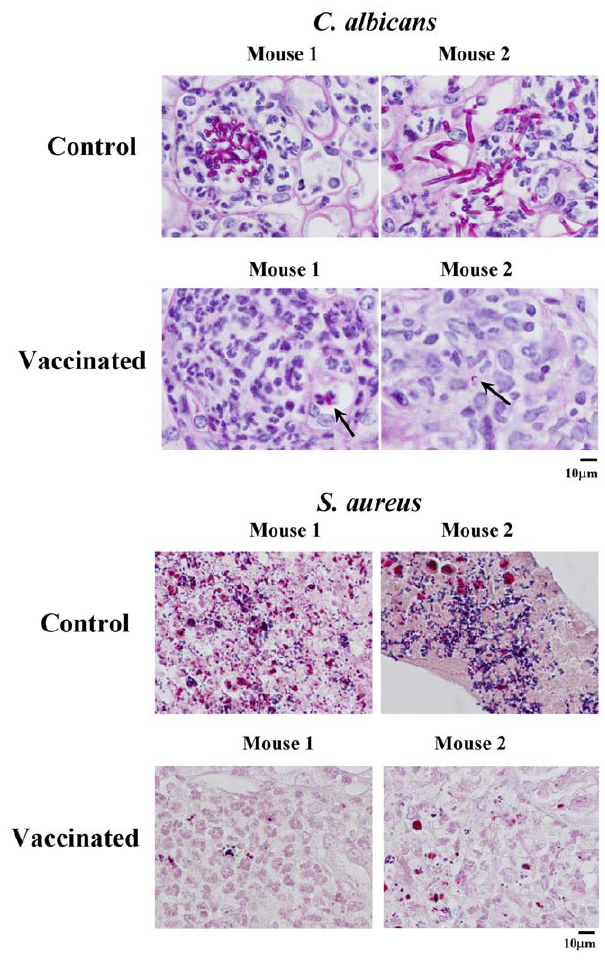
Figure 8. Unvaccinated mice had less neutrophil influx relative to fungal and bacterial burden than vaccinated mice. Represen- tative histopathological sections from kidneys from 2 mice per group are shown. Control mice infected with C. albicans had multiple abscesses with visible hyphae and pseudohyphae throughout the kidneys. Vaccinated mice infected with C. albicans had abscesses, but with far less fungus visible. Numerous abscesses were seen in both vaccinated and control mice infected with S. aureus . However, overall the abscesses in the control mice infected with S. aureus had considerably more bacteria by gram stain than the abscesses in the vaccinated mice. Sections were stained by PAS (for C. albicans ) or H&E (to show the neutrophil influx and the extent of tissue necrosis) and Gram stain (to show S. aureus dark purple clusters). Magnification=1000 6 .